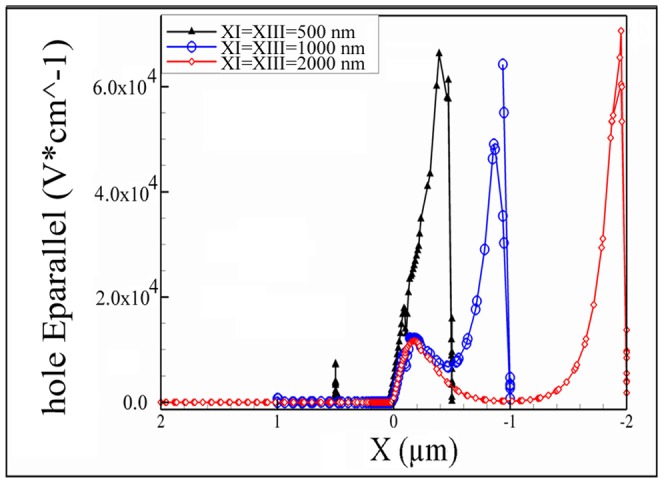
Electric field along the horizontal cut line for different zones XI and XIII lengths, VD = −1.0 V, VG = +2 V.